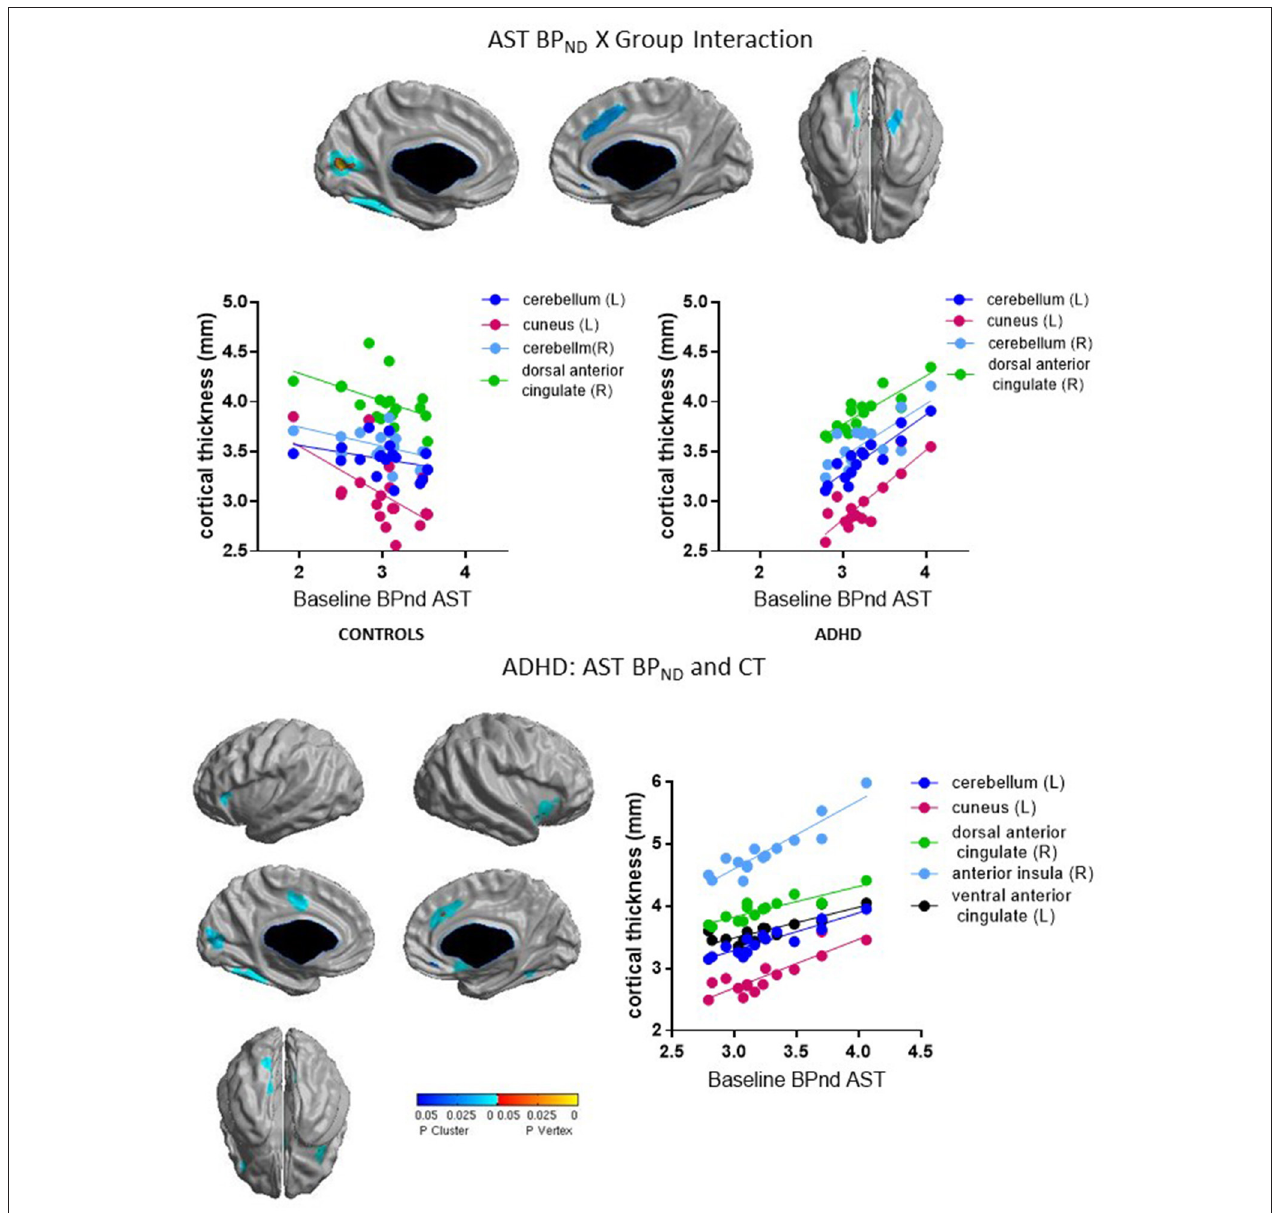
FIGURE 3 | Loci of association of baseline BP ND in AST with cortical thickness (CT).